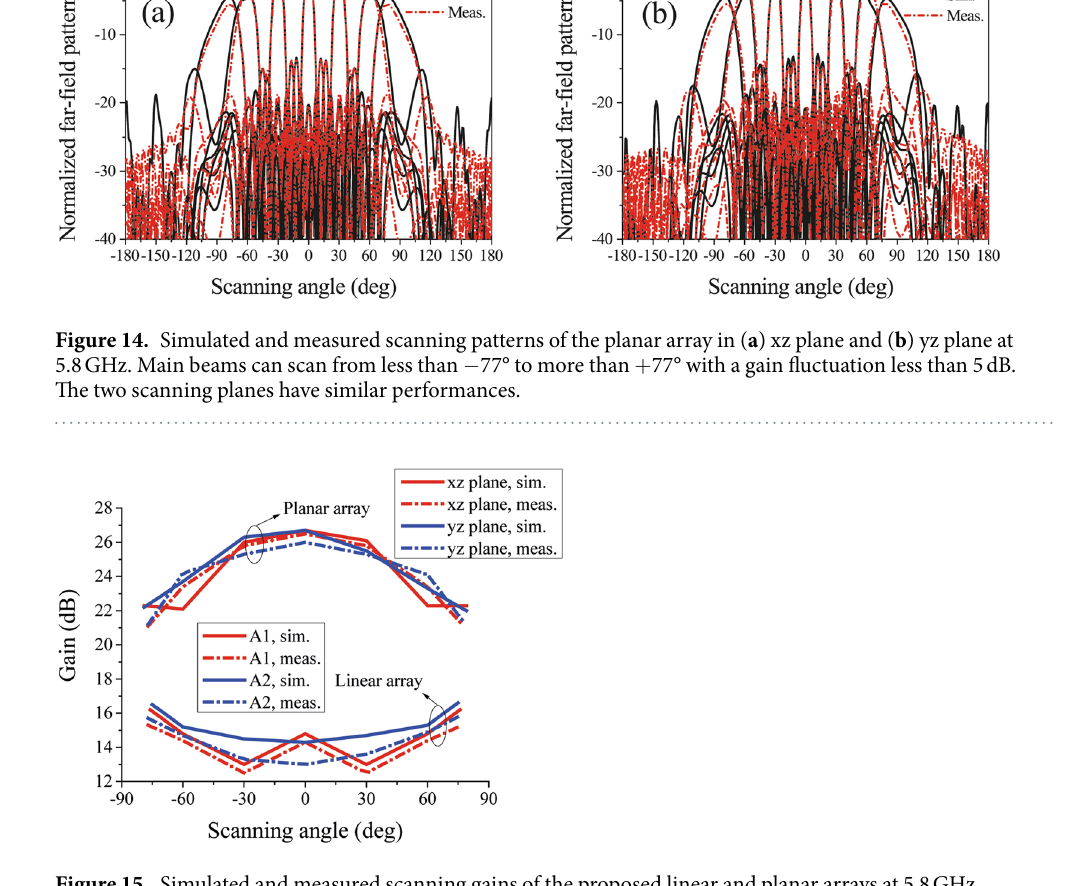
Figure 15. Simulated and measured scanning gains of the proposed linear and planar arrays at 5.8 GHz. Scanning patterns’ maximums of the linear arrays locate closed to the end-fire directions instead of the broadside direction, this characteristic can compensate the attenuation factor cos( θ ) of planar array, which makes the directivity of planar array decays not too much when beam scans to end-fire directions.